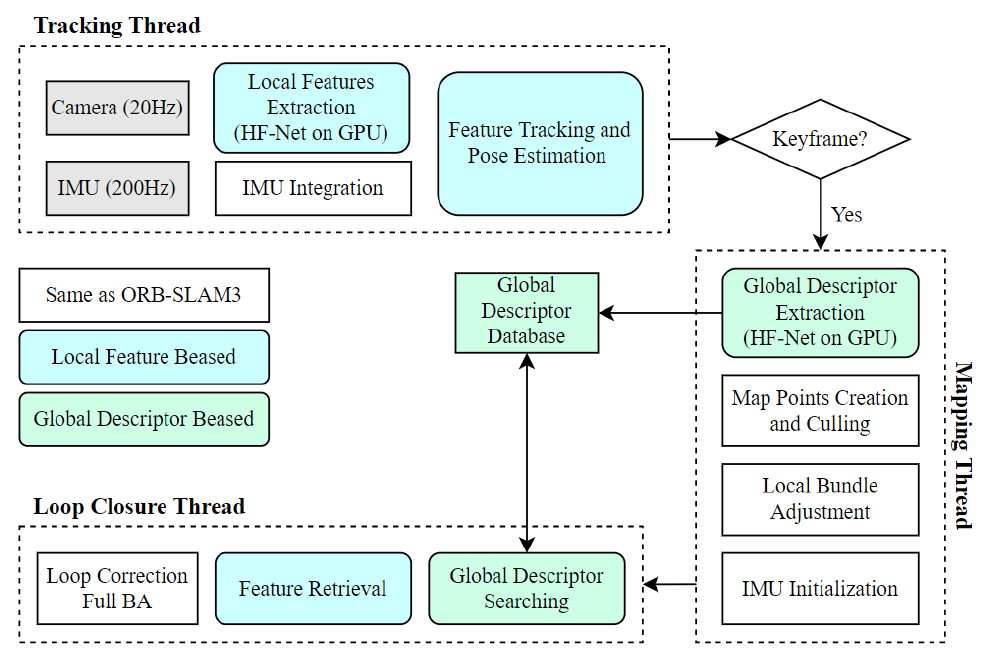
Figure 1. The main components of HFNet-SLAM